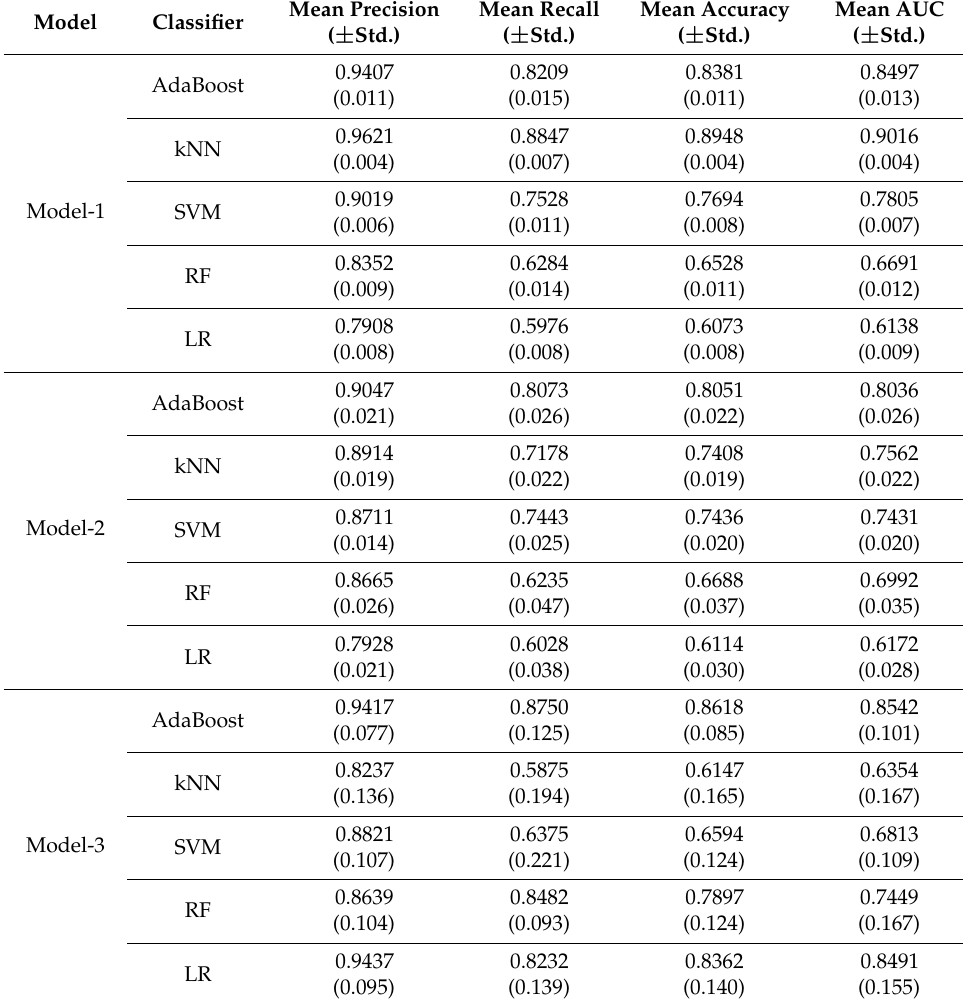
Table 4. Validation results of classifiers using stratified 10-fold cross-validation when data samples from all HD sessions were considered.